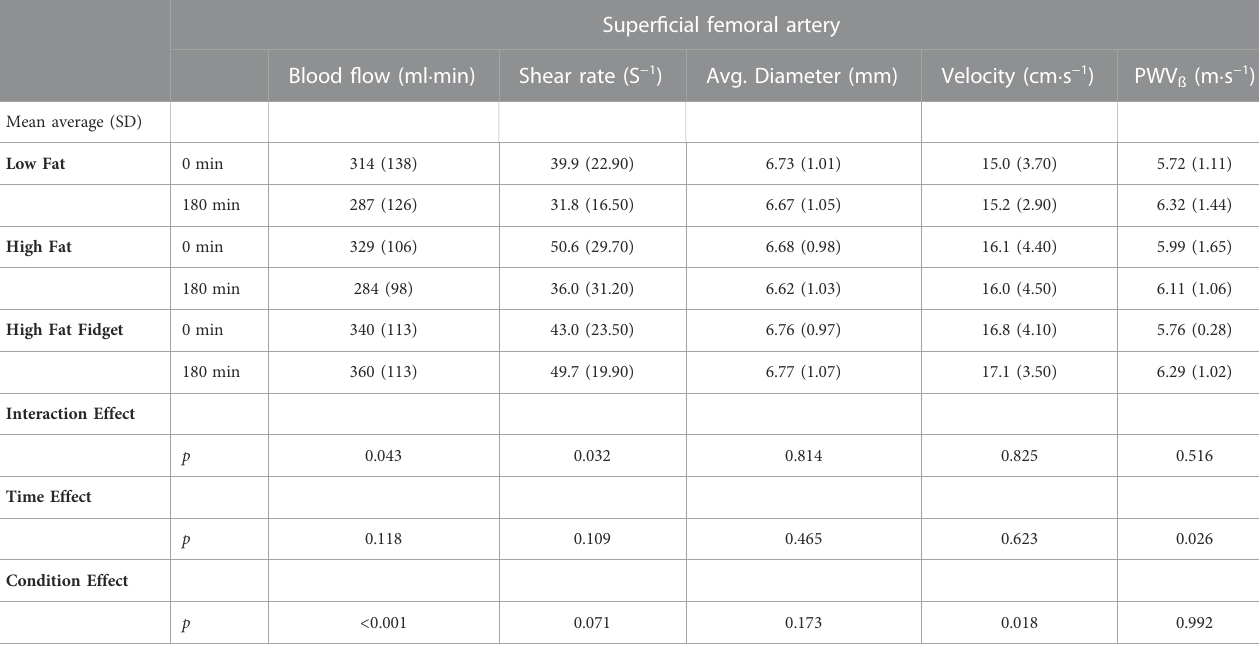
TABLE2Mean(±SD)interactionandmaineffectsforultrasound derivedsuper fi cialfemoralarterymeasures preandpostlowfat,highfatandhighfat fi dgetingsitting trials ( n =